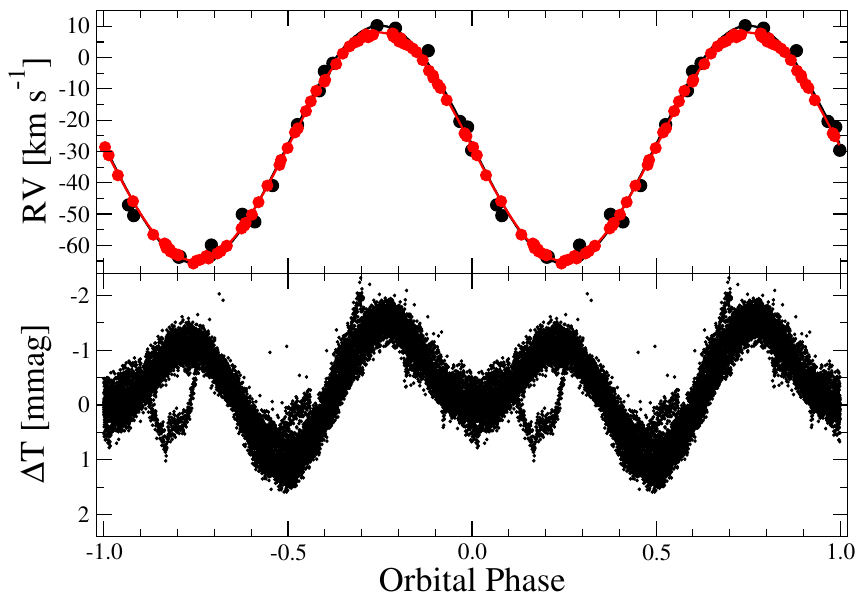
Figure 3. Top panel: Radial velocity curves of φ Aquilae plotted using data from Harper [6] and this paper. The DAO data are shown by black dots, and the best fit to these data is shown by the black solid line. The TCO data are shown in red, and the best fit is shown by the red solid line. The RVs are heliocentric. Bottom panel: TESS light curve folded with the orbital period. The relative flux scale is shown in